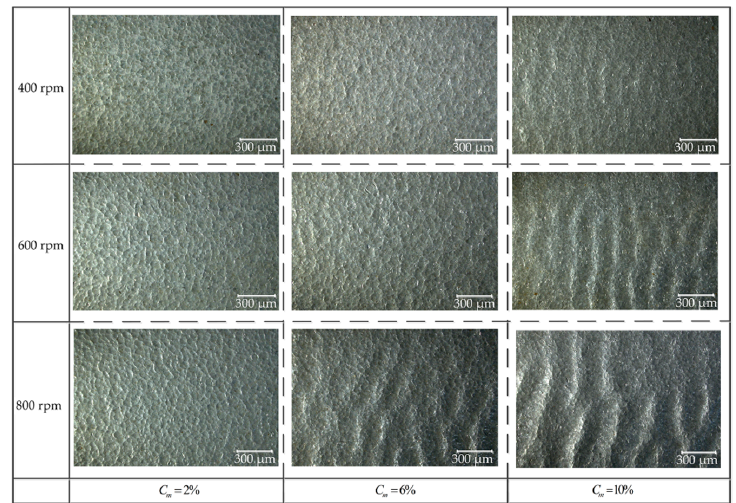
Figure 16. Blade wear surface morphology under different working conditions.